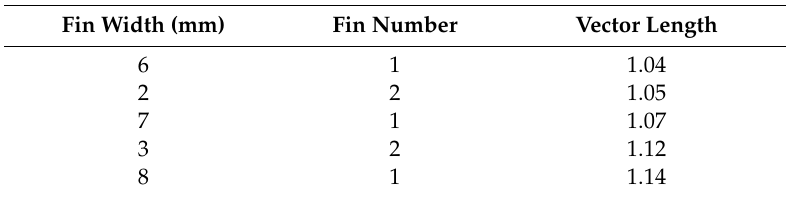
Table 5. Cases and vector